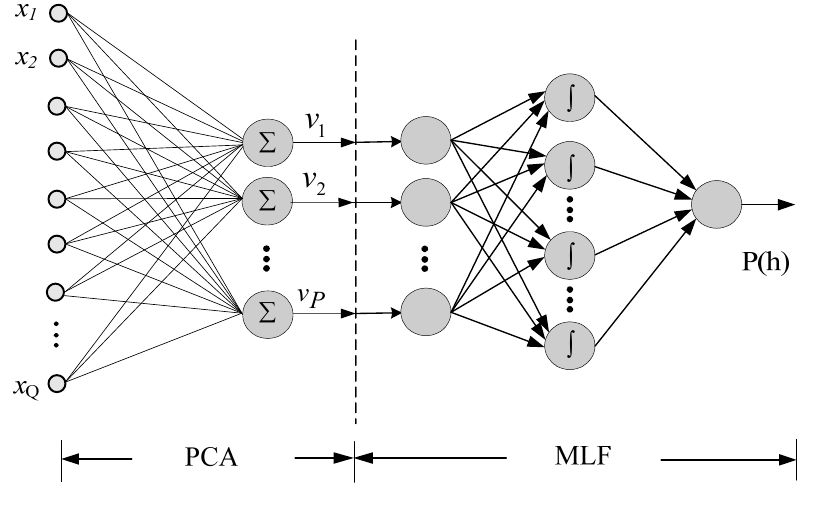
Figure 3. The proposed hybrid PCA neural